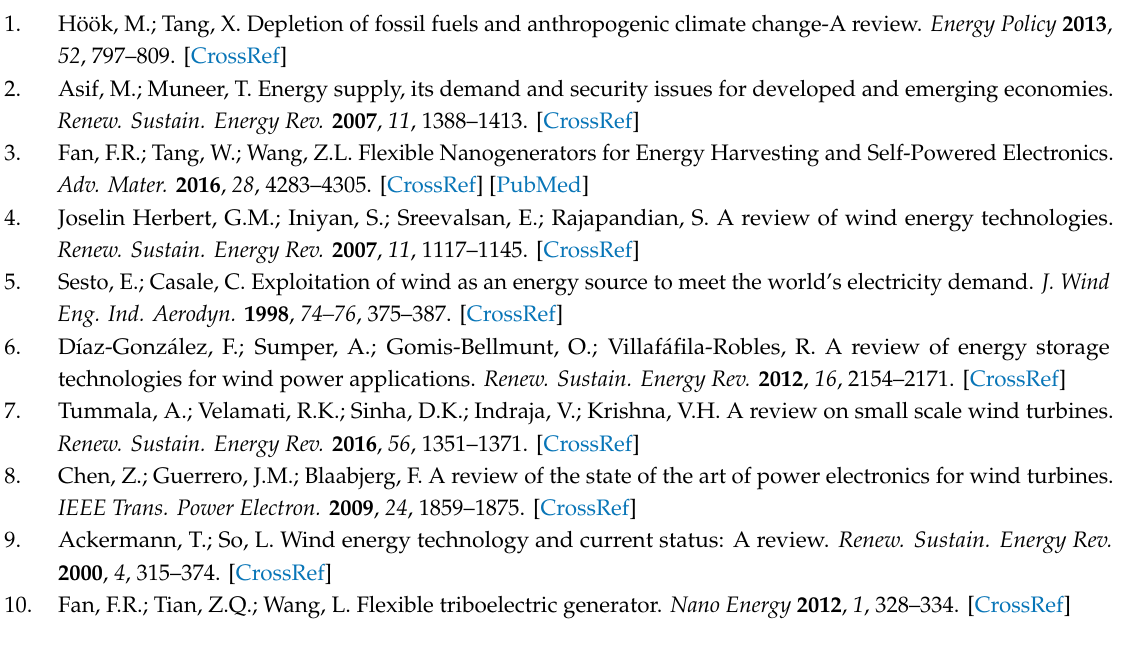
Figure S1: (A) Schematic diagram of the wind-TENG with SEM image showing the surface of bare Al electrode without WAO process. (B) Open-Circuit voltage and (C) Short-Circuit current of wind-TENG comprising bare Al and PTFE at the minimum operating wind pressure of 0.05 MPa, Figure S2: Working mechanism of the wind-TENG with the bulk PTFE under weak wind, Figure S3: Optical images of PTFE films displaying, Figure S4: (A) Load resistance dependency of the output voltage and current at wind pressure of 0.2 MPa. (B) Load resistance dependency of the output power at wind pressure of 0.2 MPa, Figure S5: Open-circuit voltages when the wind is injected into (A) Side 1 (B) Side 2 (C) Side 3 and (D) Side 4 of the integrated